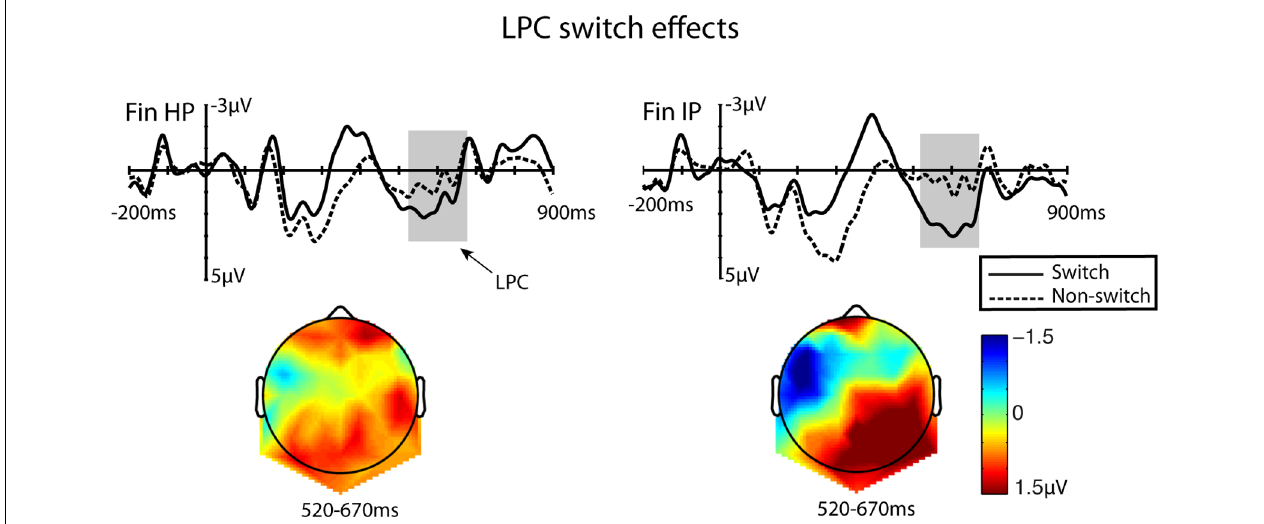
FIGURE 4 | Grand-average waveforms taken from a ROI consisting of a set of nine right-lateralised parietal electrodes to represent the late positivity found after language switches. Accompanying scalp maps were obtained for the 520–670 ms time windows for the averaged values of difference waves (language-switched minus non-switched). The 200 ms baseline is plotted, and time 0 marks the onset of the target